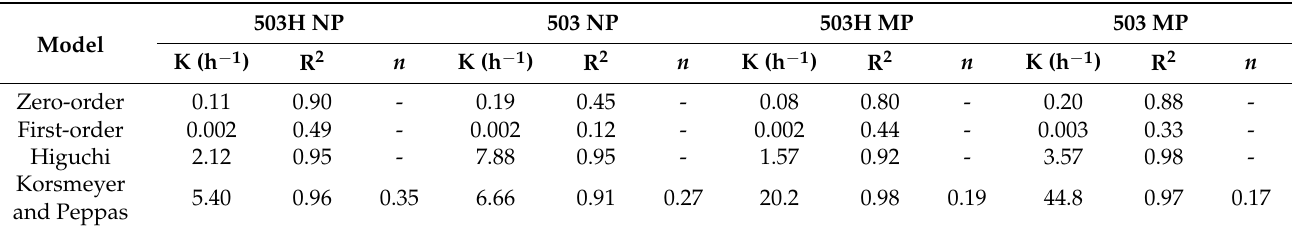
Table 3. Mathematical models and kinetic